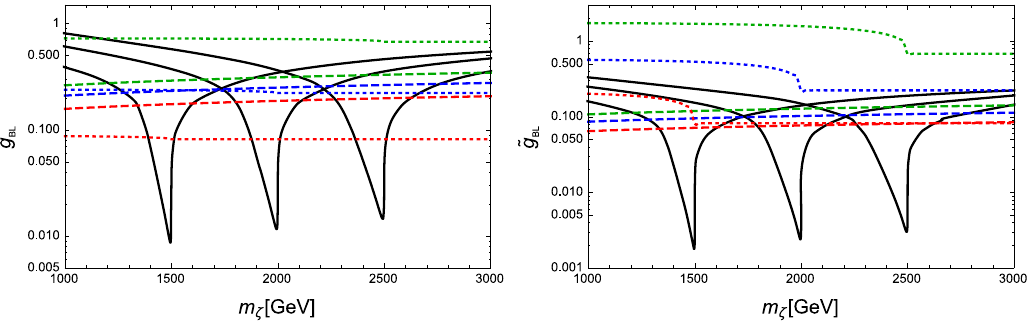
Figure 3 . Left panel: plots of ˜ g BL vs m ζ (solid black lines) that give the observed relic density for M X = 3, 4 and 5 TeV, respectively, from left to right. Here, we have fixed g ζ = ˜ g BL . The dotted lines correspond to the ATLAS bounds and dashed lines are the direct detection bounds. The red, blue and green dashed and dotted lines correspond to the bounds for M X = 3 , 4 and 5 TeV for from bottom to top. The dips in the solid lines are where the M X that constraints from the ATLAS searches for the Z ′ boson resonance and the direct DM searches are so stringent that only the parameter region near the resonance are allowed for Case (i). Right panel: same as the left panel but for g ζ = 6 ˜ g BL